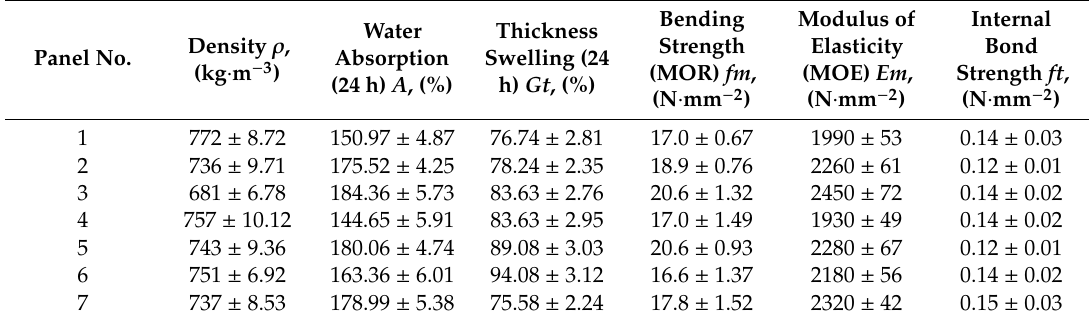
Table 1. Mechanical and physical properties of the composites produced (MOR: modulus of rupture). Density ρ Panel No.